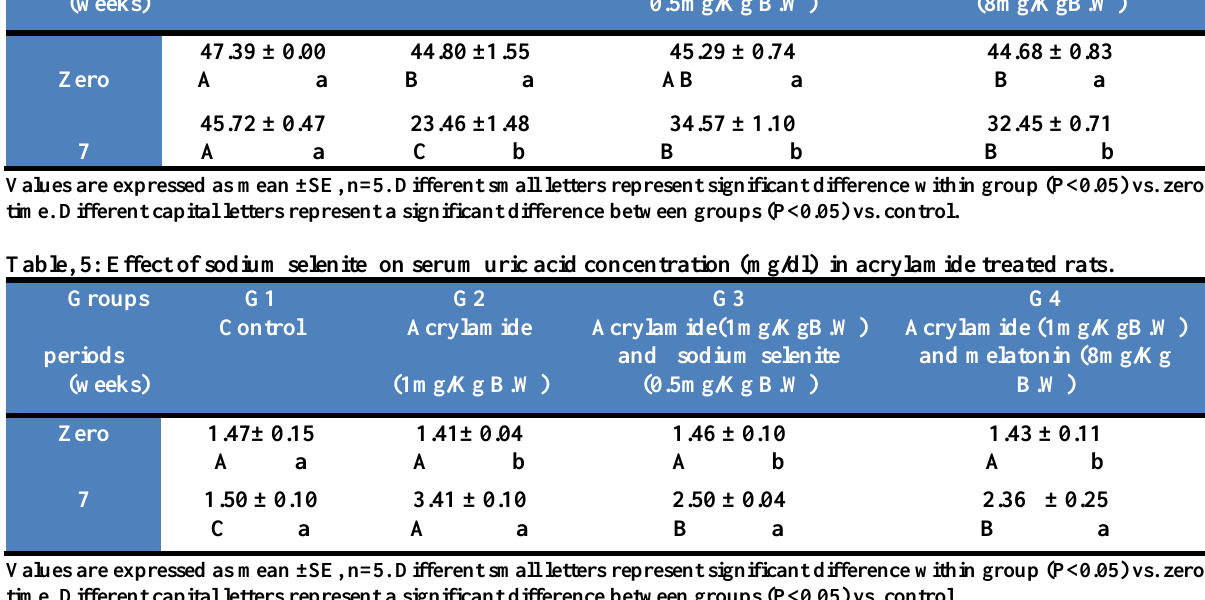
Values are expressed as mean ±SE, n=5. Different small letters represent significant difference within group (P<0.05) vs. zero time .Different capital letters represent a significant difference between groups (P<0.05) vs.